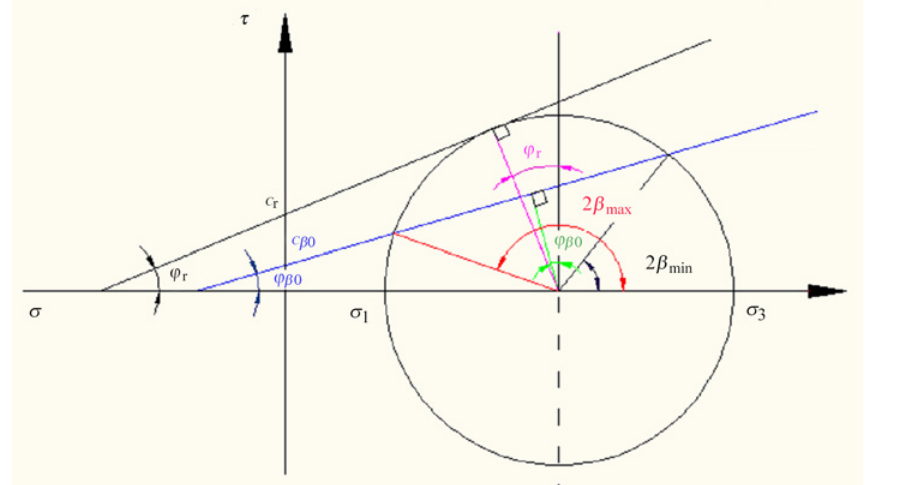
Fig 3. Mohr circle of stress for jointed rock